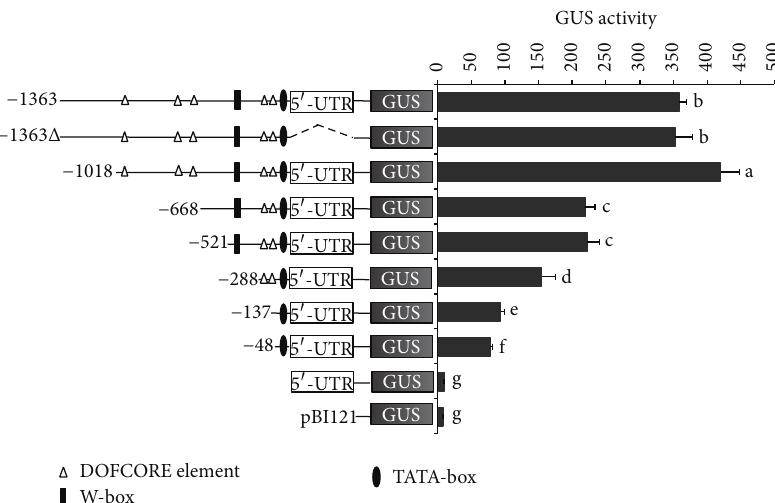
Figure 8: Deletion analysis of the GbWRKY2 promoter-driven GUS activity. Schematic diagram of the constructs used for GUS activity assays in leaves of transgenic tobacco plants is shown at left. Dash line pinpoints the deletion of the 5 󸀠 -UTR region for the construct − 1363 Δ . Quantitative analyses of GUS activity of transgenic plants driven by deletion constructs of the GbWRKY2 promoter are shown at right. Error bars represent standard deviation (SD). Data are mean ± SD from triplicate experiments. Values with different letters show significant differences at 𝑃 = 0.05 according to the Fisher’s least significant difference (LSD)